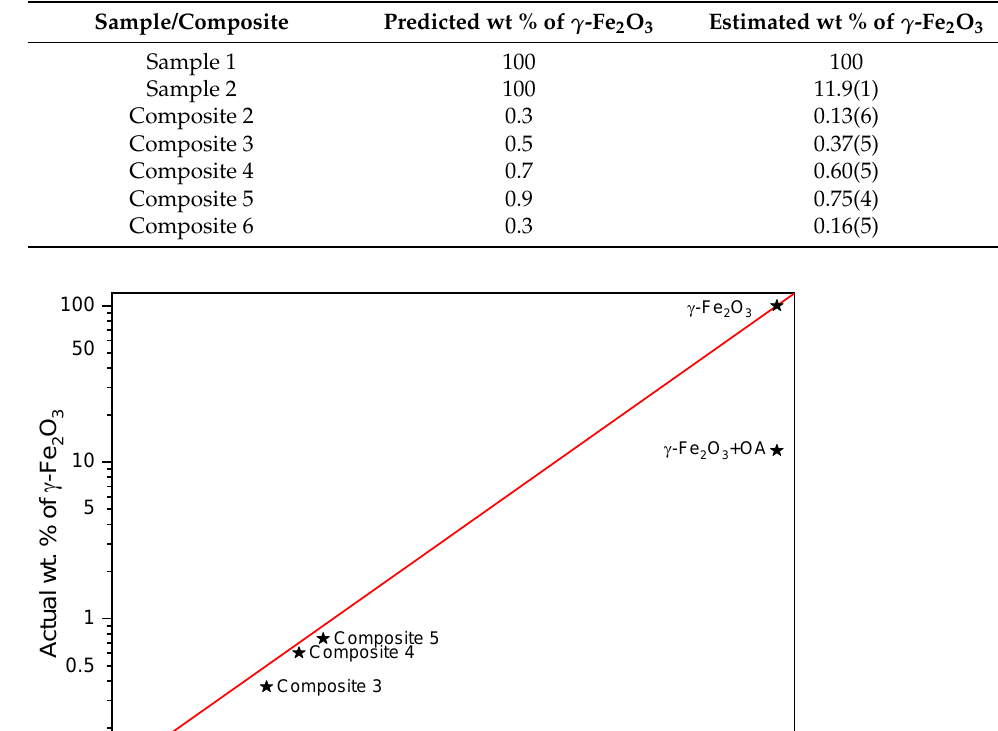
Table 1. Predicted and estimated weight percentages of γ -Fe 2 O 3 nanoparticles in the samples.